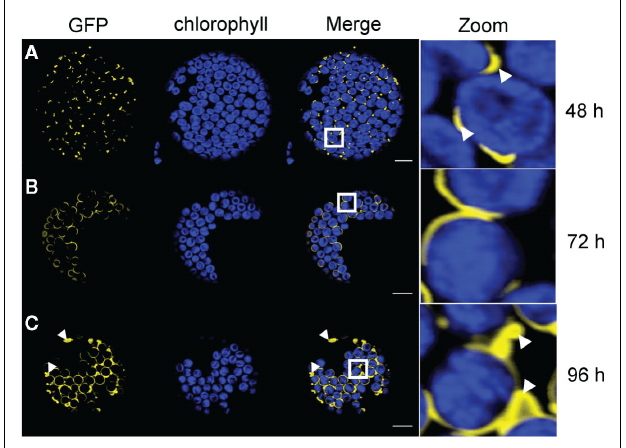
FIGURE 3 |Time course analysis of expression patterns for AtTOC64-III-GFP in N. benthamiana protoplasts. Time based confocal microscopic analysis on isolated protoplasts of N. benthamiana leaves after 35S-promoter driven in planta expression of AtTOC64-III-GFP. GFP fluorescence (GFP) in yellow, chlorophyll autofluorescence (chlorophyll) in blue, an overlay (merge) and a magnification (zoom) of representative protoplasts are shown.The white box indicates the merged region magnified under zoom. (A) Expression pattern 2days (48h) after Agrobacterium infiltration shows ring structures surrounding the chloroplasts with slight extensions proliferating from the ring. (B) Expression pattern 3days (72h) after Agrobacterium infiltration displays along the chloroplast associated circles extensions of different length. Extensions are connecting the chloroplasts with each other. (C) Expression pattern 4days (96h) after Agrobacterium infiltration shows a network of GFP labeled structures surrounding the chloroplasts and spanning though the entire protoplasts. Size bars: 10 μ